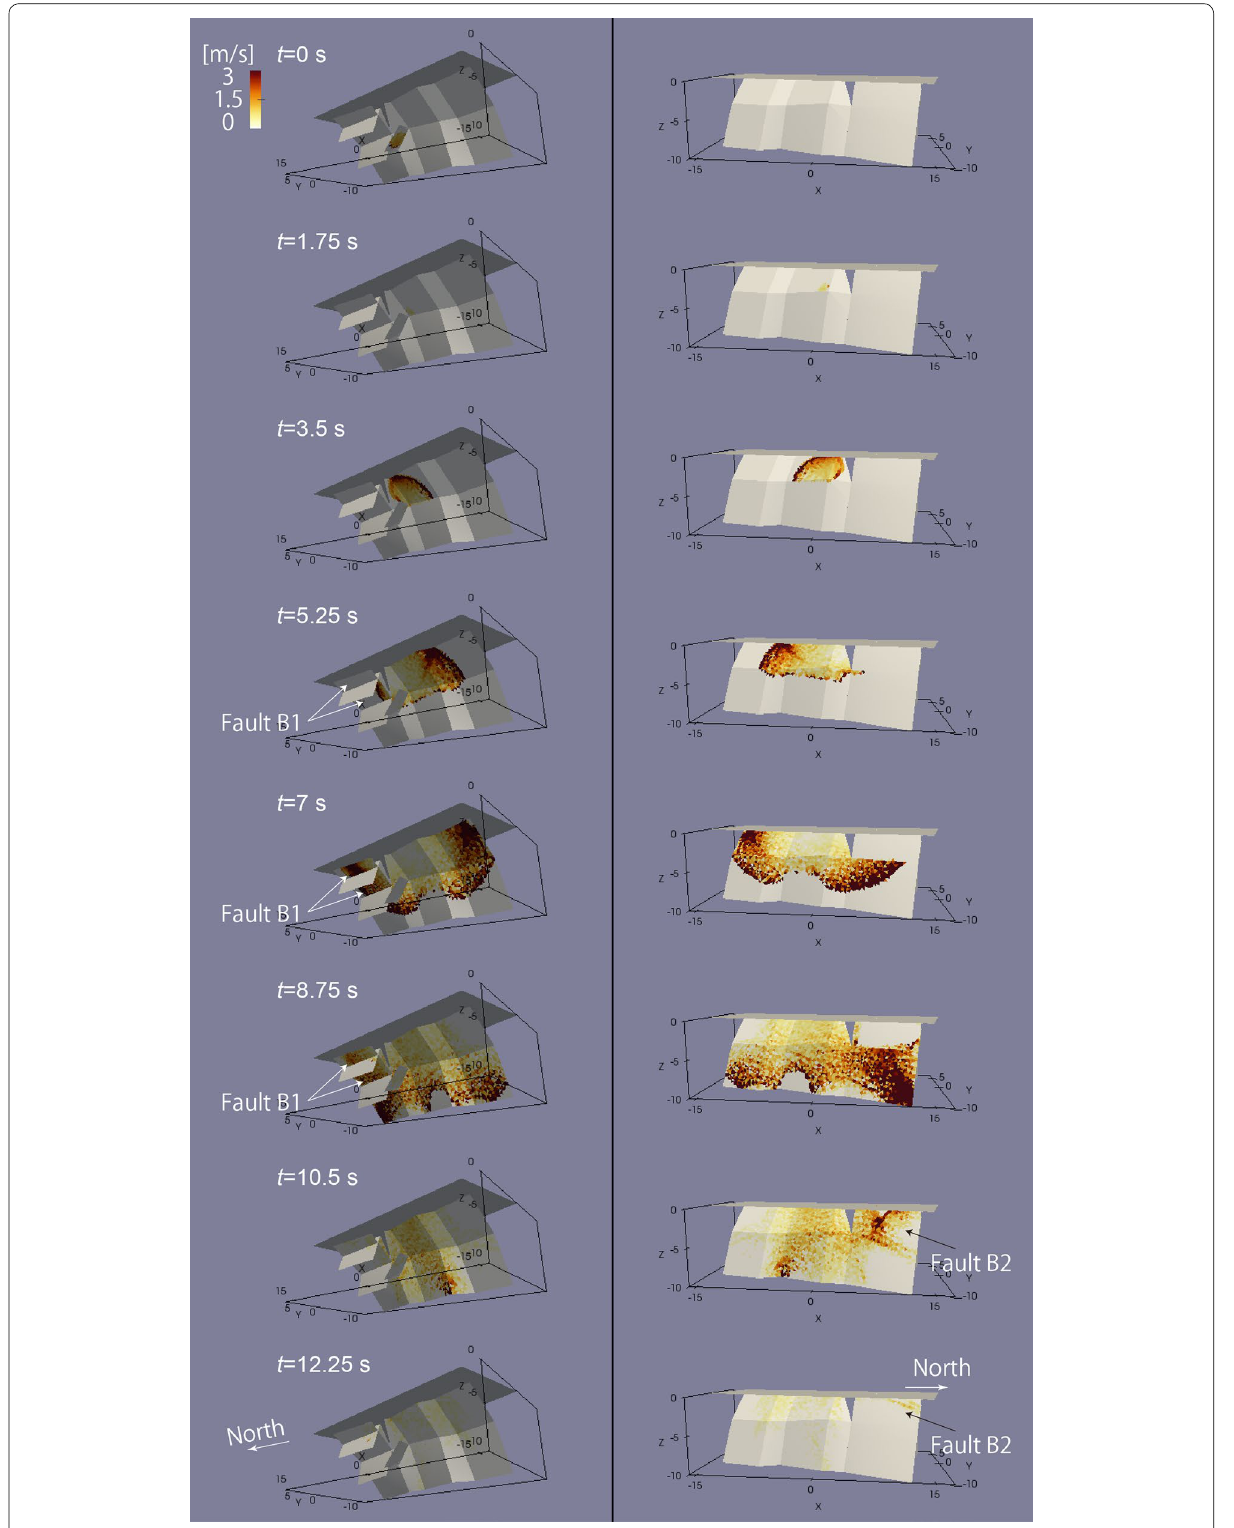
Fig. 7 Snapshots of slip rate for Models S at every 1.75 s from 0 to 12.25 s. View from west (left) and from east (right) are shown. The ruptures on overlapped branch faults are marked by arrows for Faults B1 (left) and B2